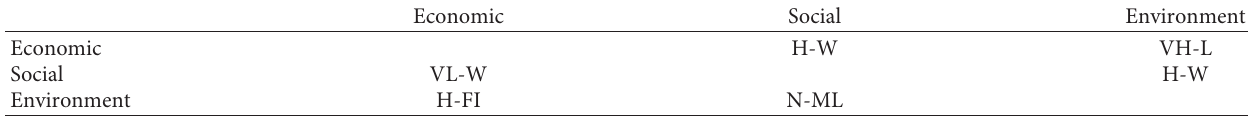
Table 15: Comparison matrix of linguistic variable in Z-number